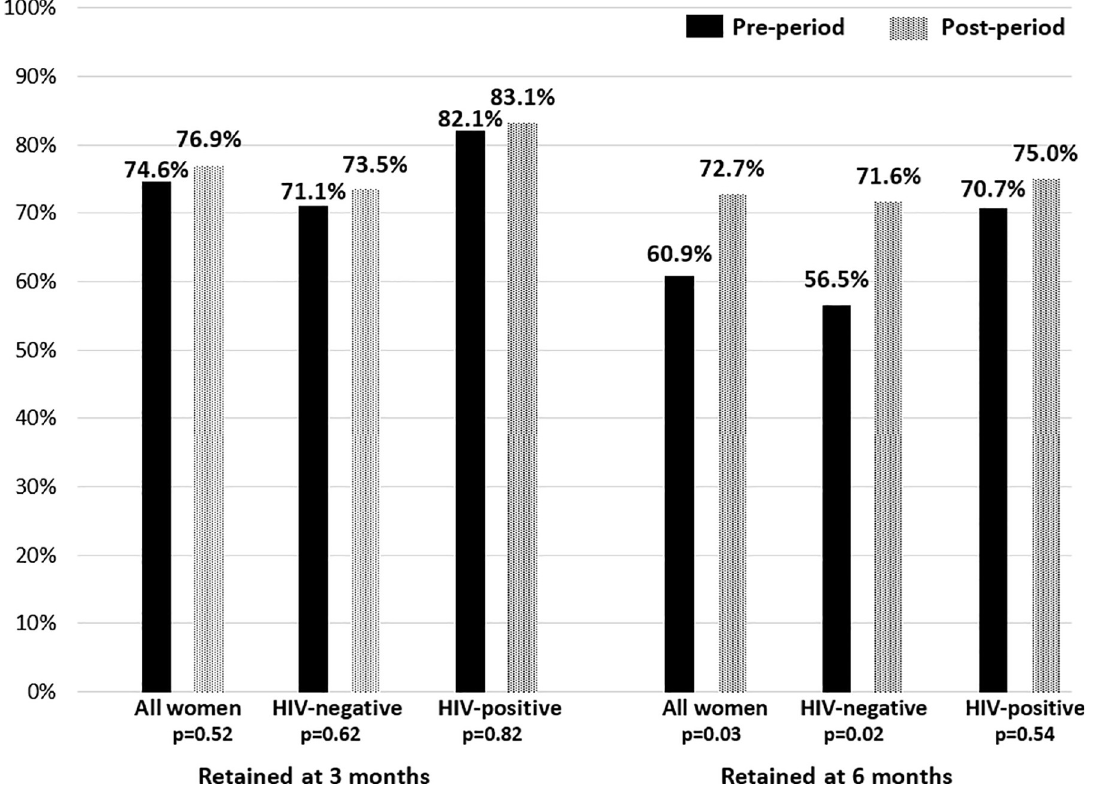
Fig 2. Women newly enrolled in ANC in the pre- and